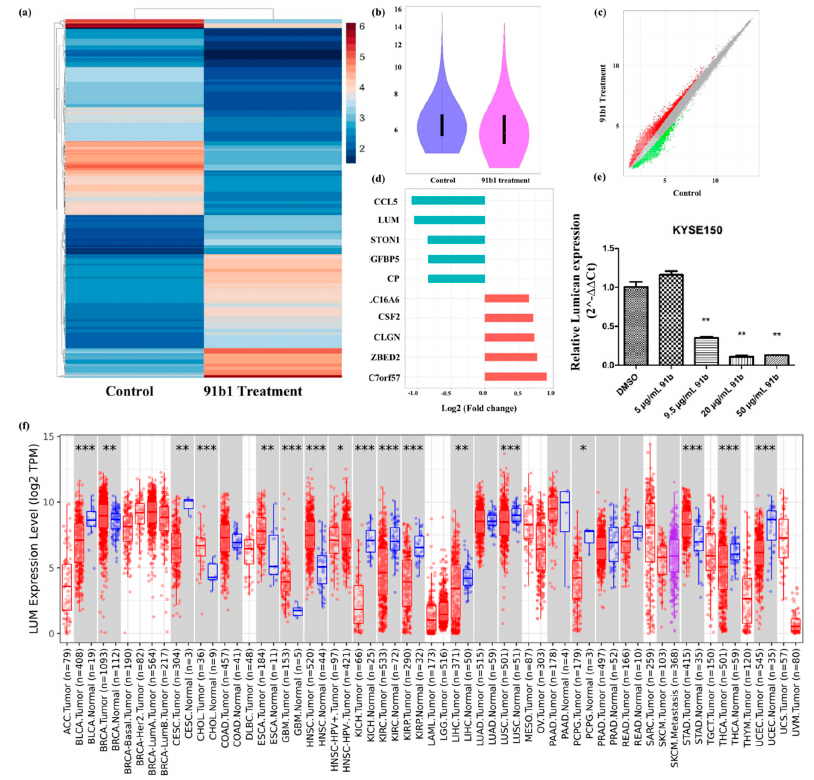
Figure 3. Lumican plays a critical role in several kinds of cancers and can be downregulated by com- pound 91b1. ( a ) Heatmap of differentially expressed genes in KYSE150 cells treated with compound 91b1 versus blank medium control, the color indicates the relative expression of genes according to color bar; ( b ) violin plot of microarray data of KYSE150 cells treated with compound 91b1 for 48 h versus blank medium control; ( c ) scatter plot of differently expressed genes in KYSE150 cells treated with compound 91b1 versus blank medium control, red dots indicate up-regulated genes, and green dots indicate down-regulated genes; ( d ) most genes regulated by compound 91b1 identified by mi- croarray analysis; ( e ) relative Lumican expression level after 48 h of treatment with different concen- trations of compound 91b1 (5 μ g/mL, 9.5 μ g/mL, 20 μ g/mL, and 50 μ g/mL) and vehicle (0.1% DMSO) in KYSE150. The relative Lumican expression level was determined by comparing with cells treated with the vehicle after normalization with the expression of β -actin using qPCR. ** p < 0.01; ( f ) pancancer analysis of Lumican by TIMER2.0, up-regulated or down-regulated genes in the tumors were compared to normal tissues for each cancer type, red dots indicate tumor tissue, bule dots indicate normal tissue, purple dots indicate to metastasis tumor tissue, * p < 0.05; ** p < 0.01; *** p < 0.001 [33].